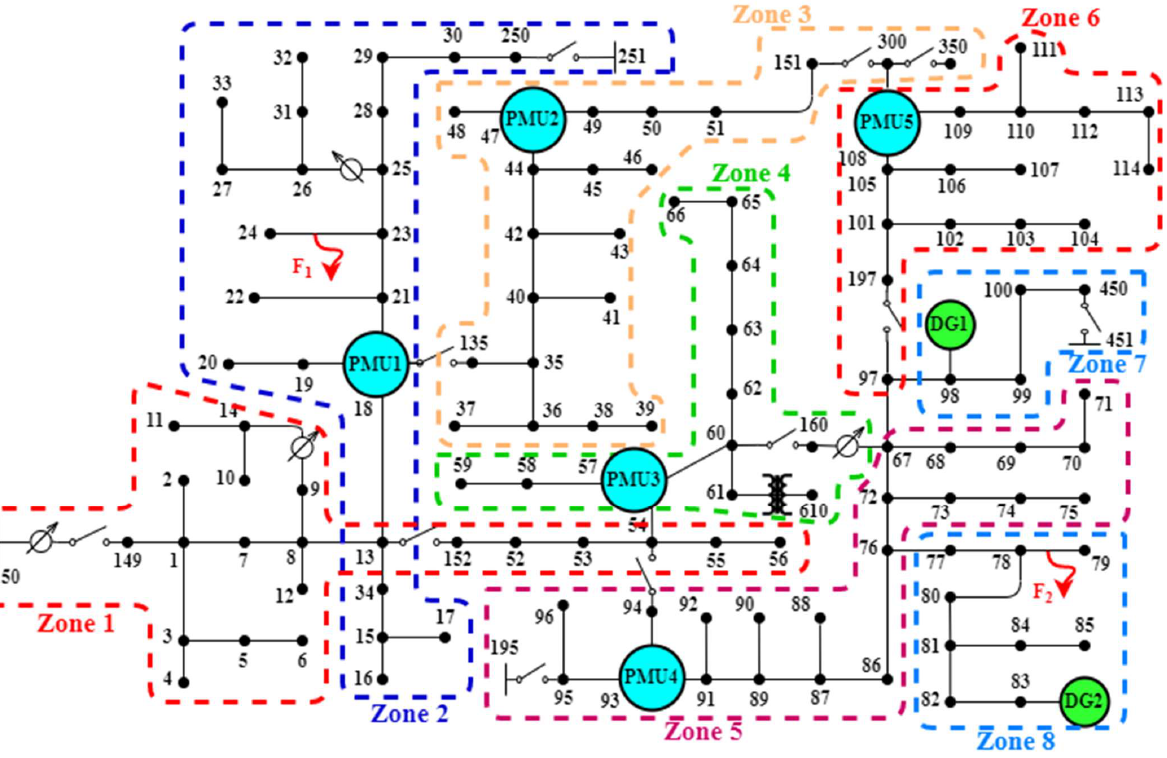
Figure 15. IEEE 123 Node Test Feeder distribution network with PMU.